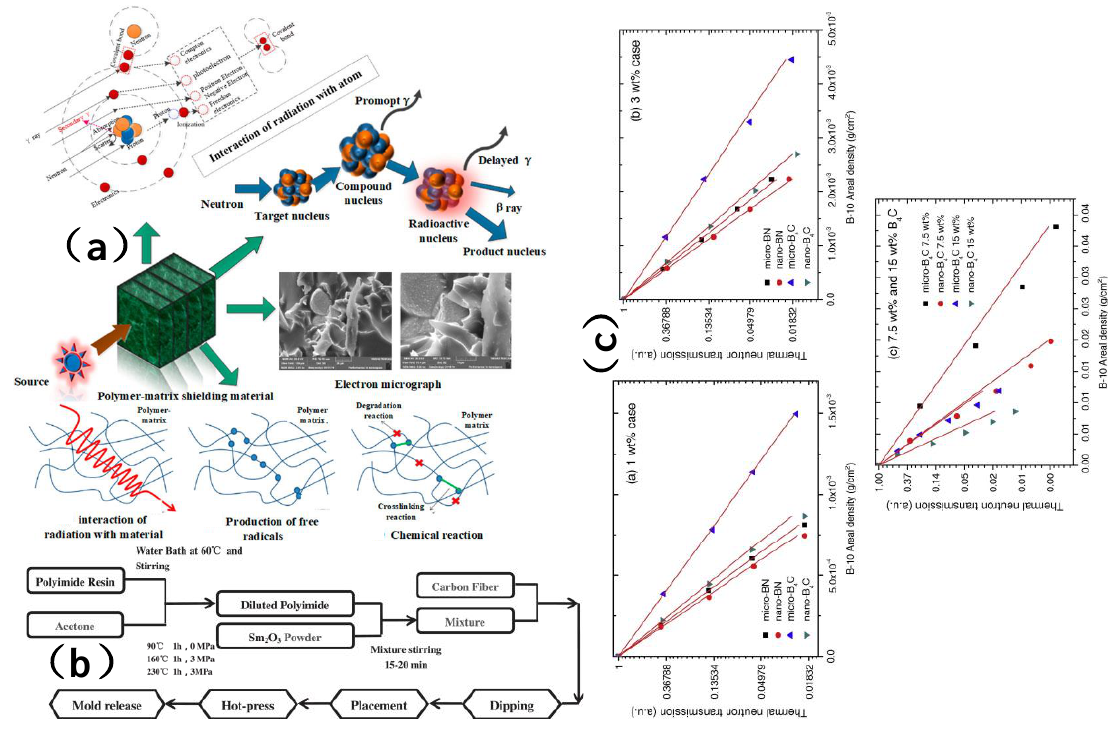
Figure 9. ( a ) A schematic diagram of the interaction between polymer-based nuclear radiation shielding materials and radiation and its effects [112]. Copyright 2021, Frontiers Media S.A. ( b ) A flow chart showing the manufacturing method leading to continuous a carbon fiber-reinforced Sm 2 O 3 /polyimide shielding material [113]. Copyright 2015, Elsevier. ( c ) Thermal neutron transmit- tance of composite membrane shielding material [114]. Copyright 2014, Elsevier.